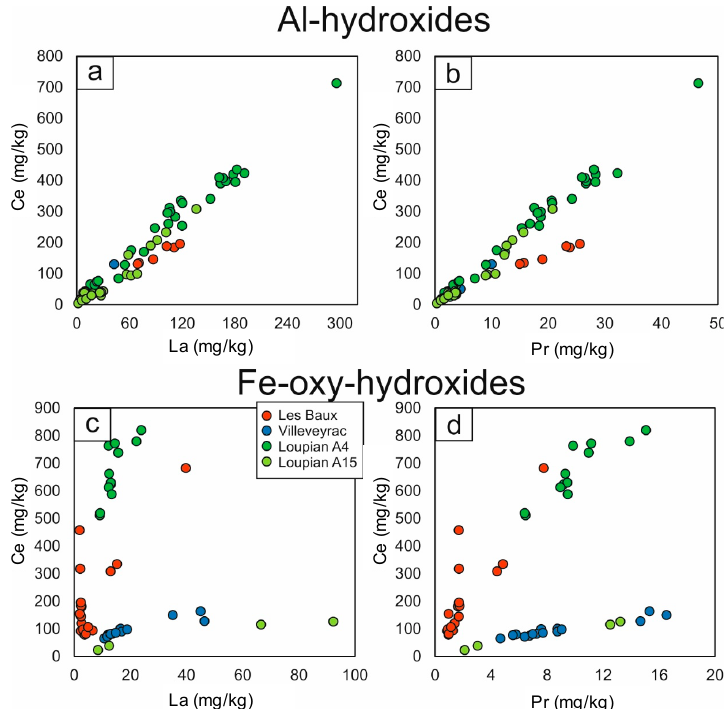
Figure 8. ( a ) La vs. Ce and ( b ) Ce vs. Pr (mg/kg) binary diagrams of in ‐ situ LA ‐ ICP ‐ MS analyses, on Al ‐ hydroxides; ( c ) La vs. Ce and ( d ) Ce vs. Pr (mg/kg) binary diagrams of in ‐ situ LA ‐ ICP ‐ MS analyses, on Fe ‐ oxy ‐ hydroxides.